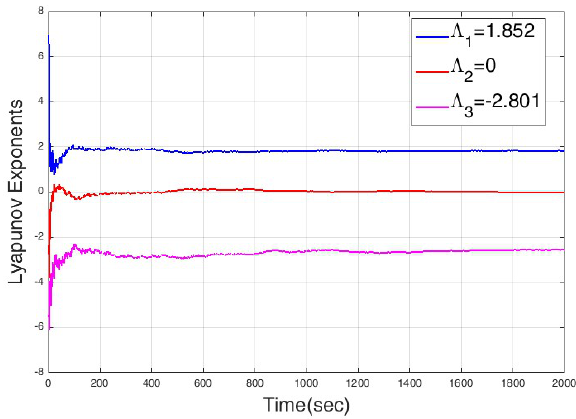
Figure 2. Lyapunov exponent of system (33).